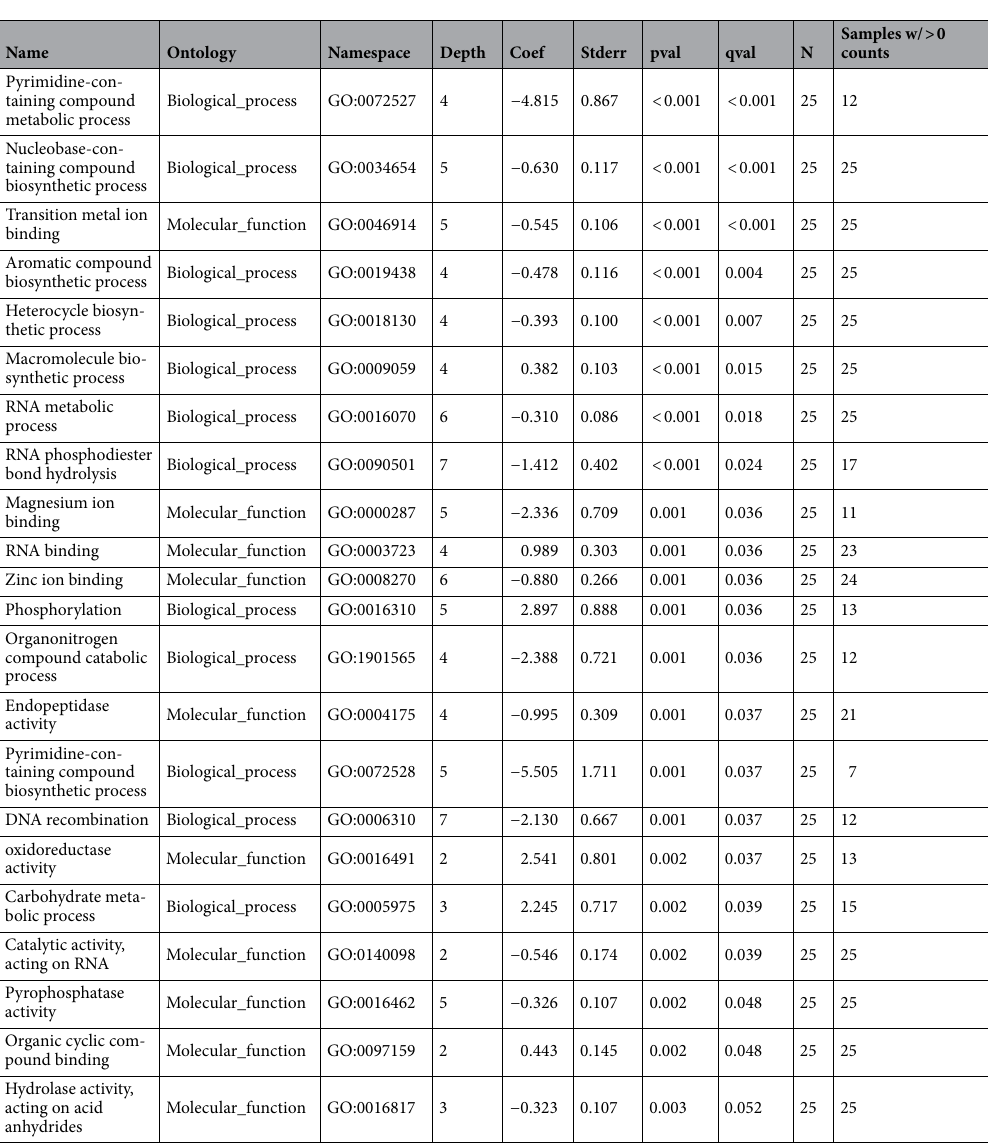
Table 5. MaAsLin2-derived significant gene ontologies associated with COVID-19 disease outcome (deceased vs. survived). Comparisons were conducted using compositional transformed and CLR normalized count matrices, controlled for the random effect of patient ID, and adjusted for multiple test comparisons using the Benajmini Hochberg correction method. A full list of statistically significant GO terms in COVID-19 Deceased vs. Survived can be found in Suppl. Table